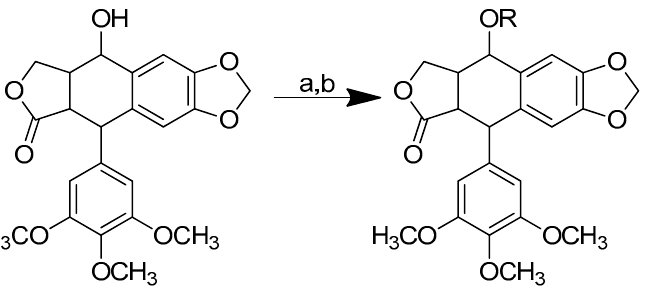
Scheme 17. Synthesis of the podophyllotoxin–amino acid conjugates. Reagents and conditions: